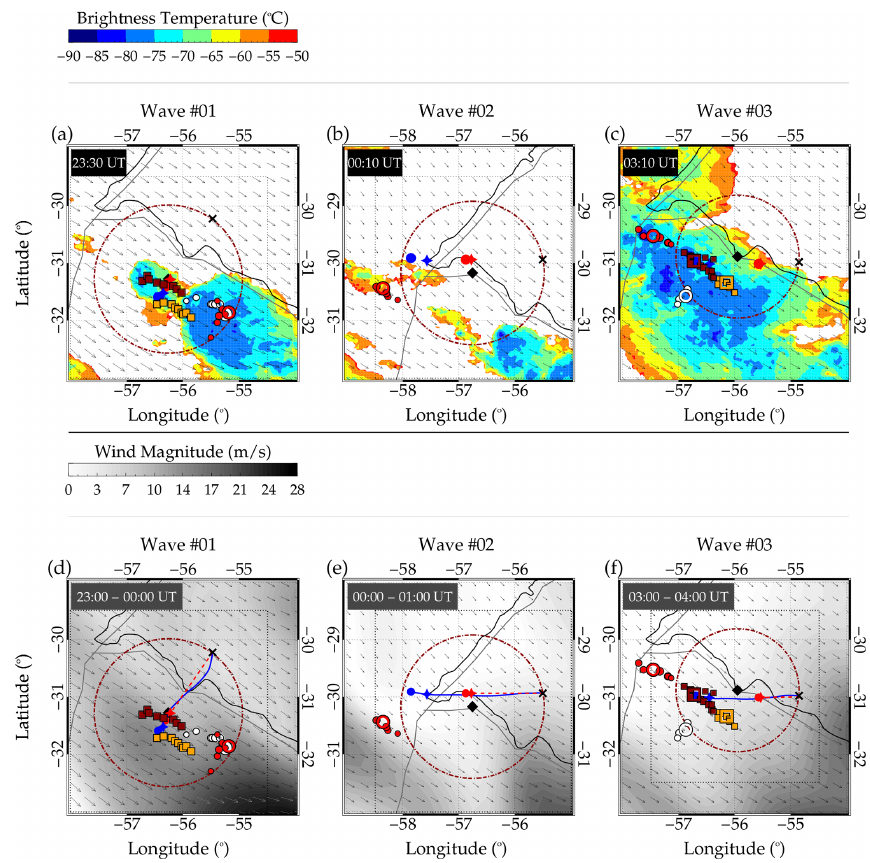
Figure 13. A combined plot of tracked individual convective cores/overshooting tops of Wave no. 01 with Cs no. 01, no. 02, no. 03 and no. 04, Wave no. 02 with C no. 05, and Wave no. 03 with Cs no. 06, no. 07, no. 08, and no. 09 in space and time. In the upper panels (a) – (c) , the Cs are plotted over the map with the CTBT map at each wave event excitation time and the wind vector, whereas the lower panels (d) – (f) are the wind magnitude and vector. The wind corresponds to the hour in which the waves were excited. The arrows show the direction of the wind at the